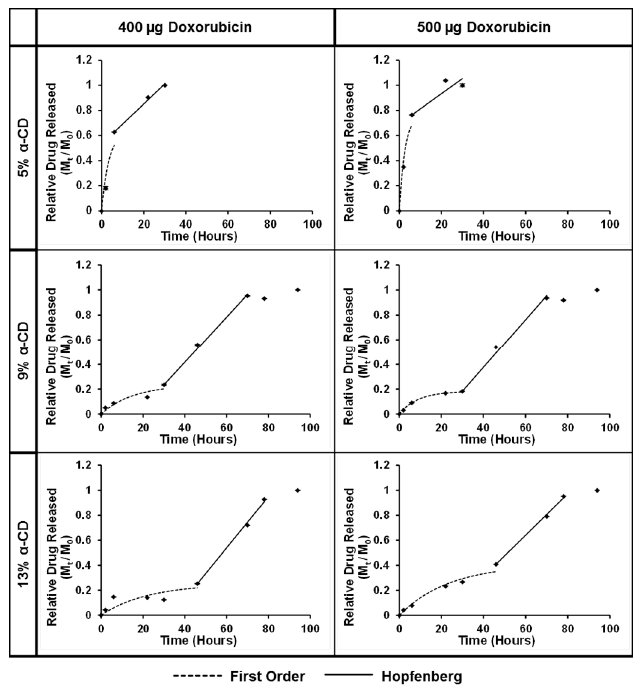
Figure 7. Drug release profile with model fitting for the PGS-PEGMEMA 2/ α CD hydrogels with 2% polymer and 5%, 9% and 13% α CD with payloads of 400 and 500 μ g. Phase I was fitted to the First Order Kinetic model (dotted) and Phase II was fitted to the Hopfenberg model (solid).